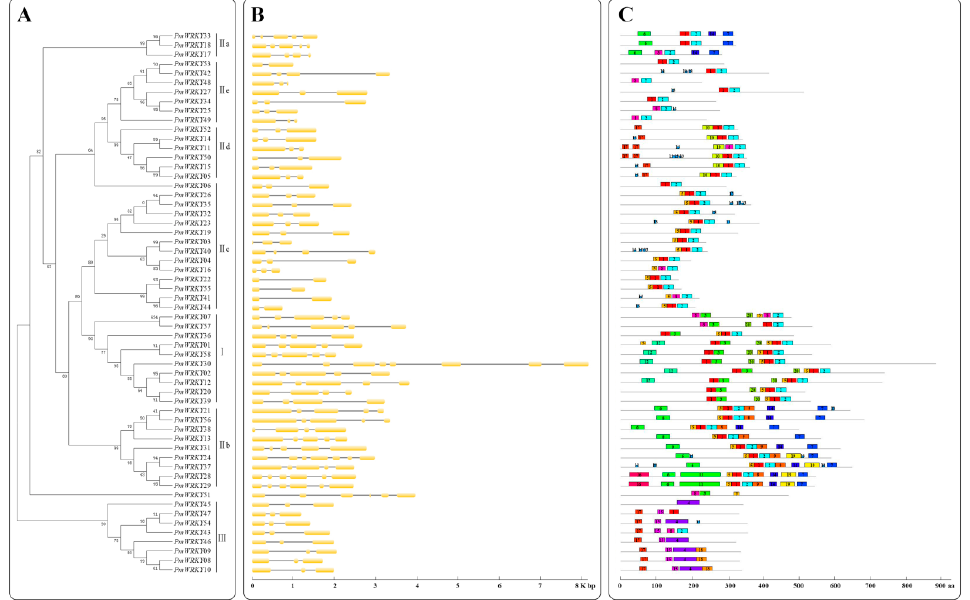
Figure 3. Relationships, gene structure and motif compositions of PmWRKYs. ( A) The full-length PmWRKY protein sequences were aligned by ClustalW and the unrooted phylogenetic tree was constructed using MEGA5.1 program by the neighbor-joining method with 1,000 bootstrap replicates. ( B ) Exon/intron structures of the PmWRKYs . Yellow boxes represent exons and black lines represent introns. ( C ) Conserved motif analysis of PmWRKYs by MEME. Different motifs are represented by different colored boxes with numbers 1–20.